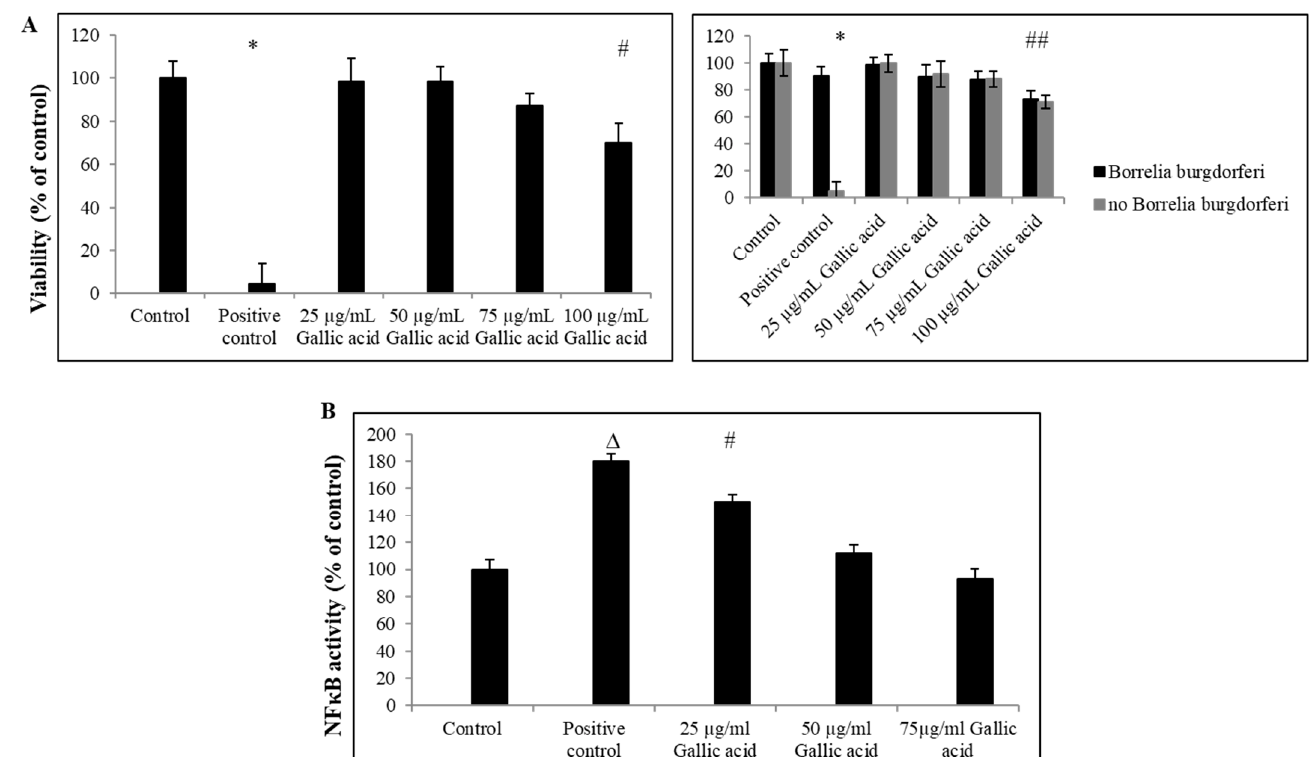
Figure 4. Effect of gallic acid on NF κ B activity. Viability of CD14+ monocytes ( A , left panel ) and NF κ B reporter cells ( A , right panel ) upon treatment with B. burgdorferi . 1—control cells not stimulated with B. burgdorferi ; Positive control—control cells stimulated with B. burgdorferi at cells:bacteria 1:5 ratio or 100% dead cells; control—DMSO only (0.05%). Activity of NF κ B ( B ). NF κ B reporter cells were treated with gallic acid upon PMA stimulation. Activity was assessed using NF κ B activity ELISA kit after 24 h post-treatment. 1—control cells not stimulated with PMA; positive control—control cells stimulated with PMA at 3 nM concentration; # p ≤ 0.05, ∆ p ≤ 0.01, * p ≤ 0.001; control—DMSO only